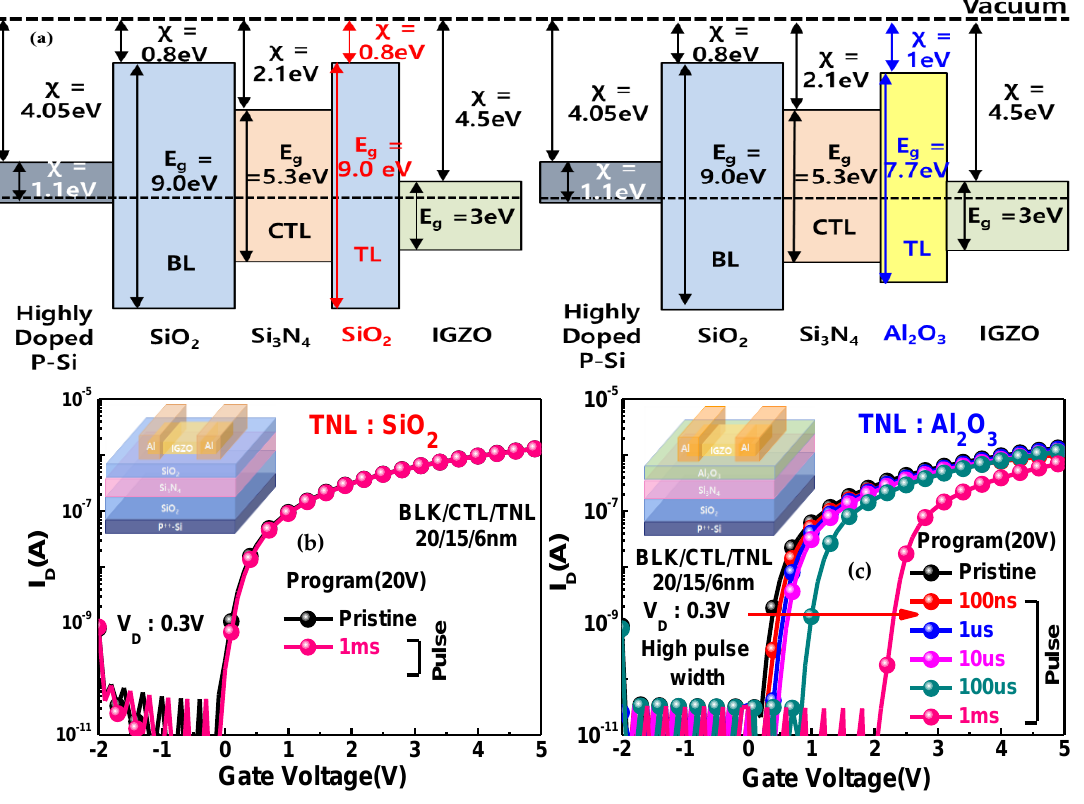
Figure 4. Schematics of ( a ) the energy band diagrams of TFT flash memory devices with SiO 2 and Al 2 O 3 as the TNL. Programing behaviors under various pulse times for a -IGZO TFT flash memory devices with ( b ) SiO 2 and ( c ) Al 2 O 3 TNLs.